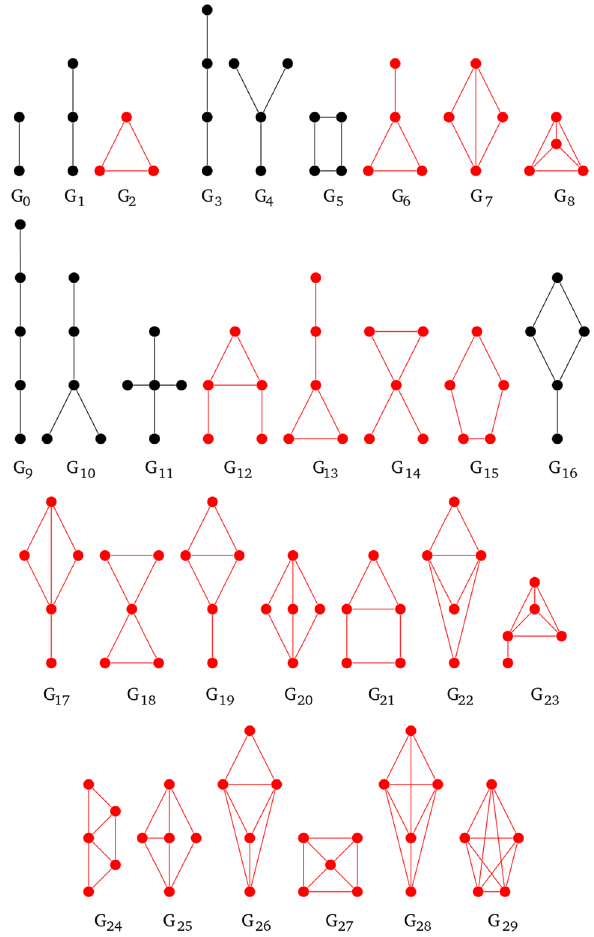
Figure 4. All undirected graphlets build on 2, 3, 4 and 5 vertices. The ones in black color after modifications could occur in Petri nets, while the red ones do not fulfill bipartite